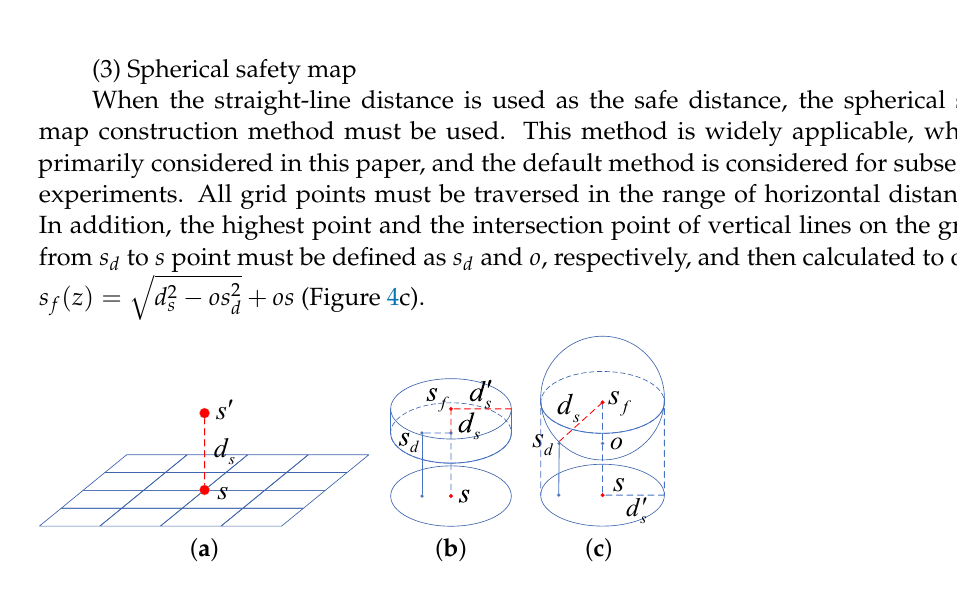
Figure 4. Description of different safety maps. ( a ) Vertical safety map. ( b ) Horizontal safety map. ( c ) Spherical safety